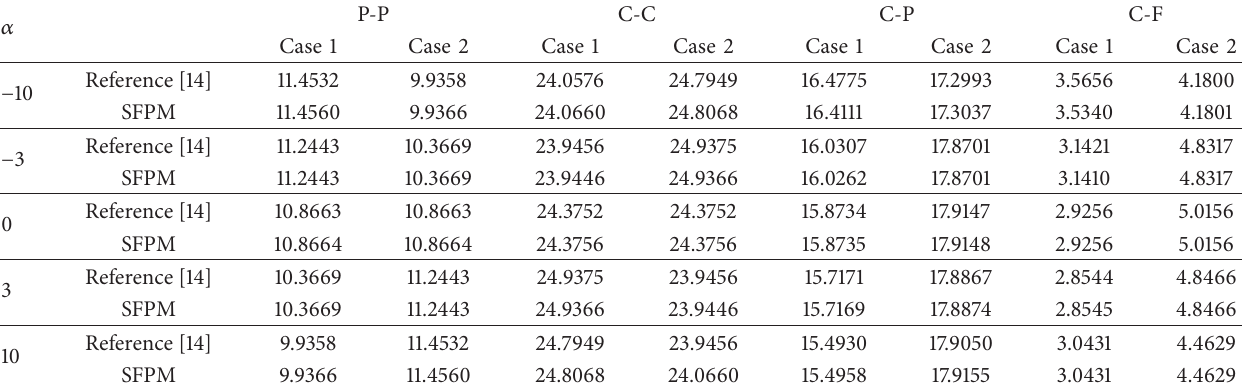
Table 9: Nondimensional fundamental natural transverse frequencies 𝜔 𝑖 for axially FG beams with respect to the gradient index. 𝛼 − 10